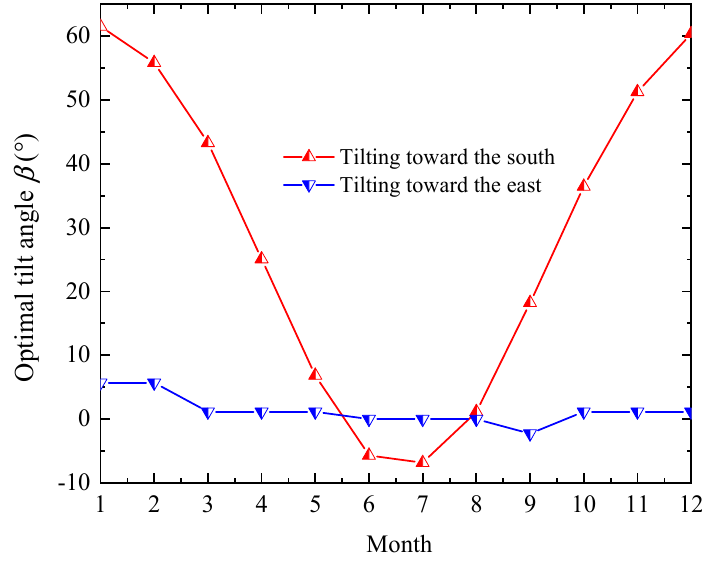
Figure 7. Monthly optimal tilt angle in Nanjing city.